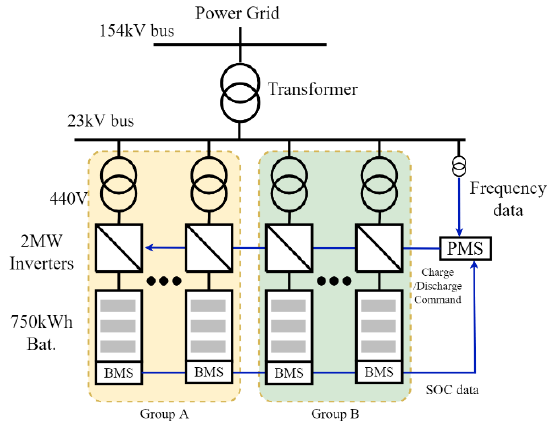
Figure 1. Configuration of energy storage system for frequency regulation.